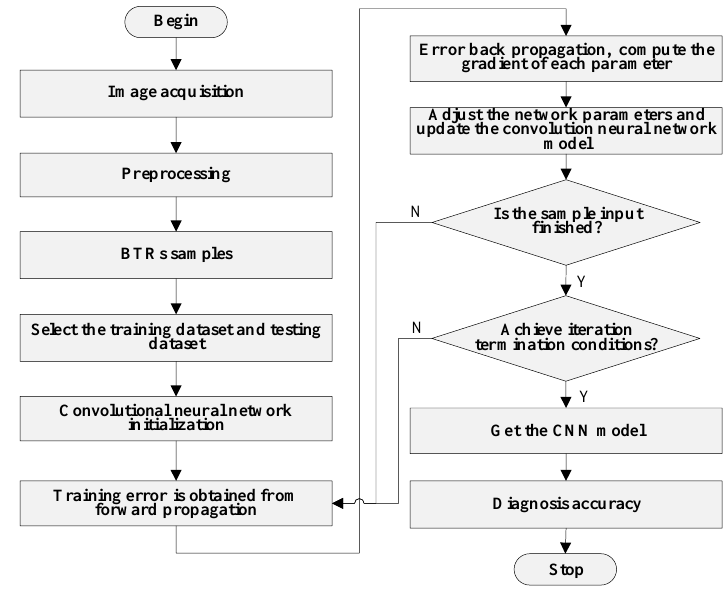
Figure 4. The algorithm flow chart.